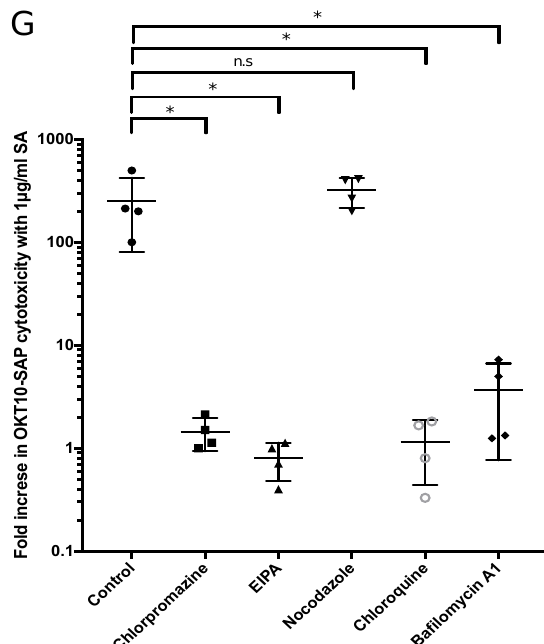
Figure 4. Inhibition of SA-mediated augmentation of saporin cytotoxicity in Daudi Cells by the var- ious pharmacological agents studied. Effect of chlorpromazine ( A ), EIPA ( B ), nocodazole ( C ), cyto- chalasin D ( D ), bafilomycin A1 ( E ), and chloroquine ( F ) on the cytotoxicity of saporin and saporin used in combination with 1 µg/mL of SA. ( A – F ): Dose–response curves determined by XTT assay for saporin on Daudi lymphoma cells with each agent in the absence ( ▼ ) and presence ( △ ) of SA. In each chart, the data for saporin without each agent in the absence (●) and presence ( ○ ) of SA are also presented for comparison. Each datum point represents the calculated mean of four experi- ments each performed in quadruplicate cell cultures and the error bars one standard deviation ei- ther side of this mean. The EC50 obtained from each curve is shown against the perpendicular dot- ted line. ( G ): Fold increases in saporin cytotoxicity with 1µg/mL SA in control (●), chlorpromazine ( ■ ), EIPA ( ▲ ), nocodazole ( ▼ ), cytochalasin D ( ◆ ), chloroquine ( ○ ), and bafilomycin A1 (□). Dots represent fold increase for individual experiments with the lines showing the mean and one stand- ard deviation either side of this mean. Augmentation was significantly abrogated by chlorproma- zine ( p = 0.0286 *), EIPA ( p = 0.0286 *), cytochalasin D ( p = 0.0286 *), chloroquine ( p = 0.0286 *), and bafilomycin A1 ( p = 0.0286 *) as determined by Mann–Whitney U-Test. CPZ: chlorpromazine; CQN: chloroquine; BAF: bafilomycin A1; CYT-D: cytochalasin D; NOC: nocadazole.